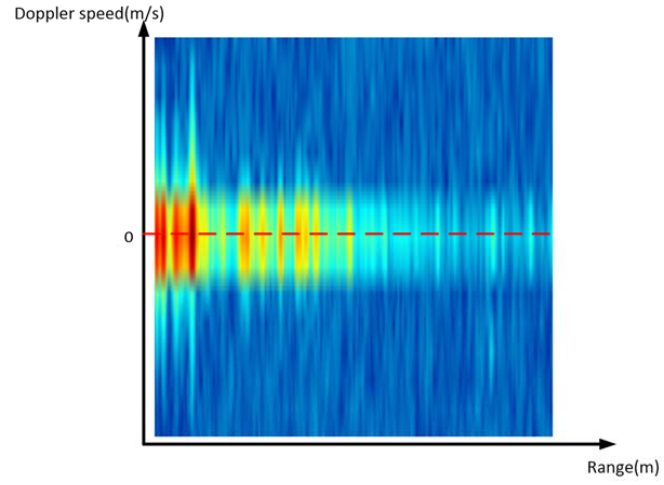
Figure 3. The visualization of range–Doppler data.